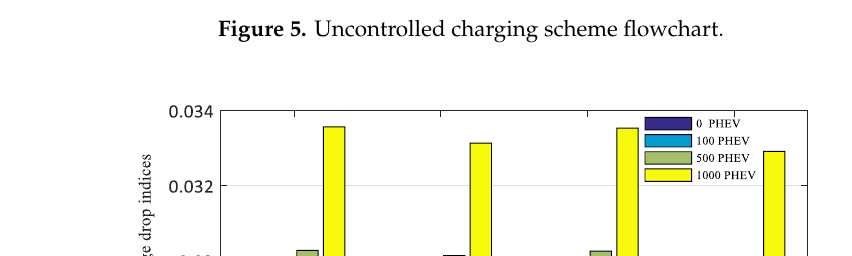
Figure 5. Uncontrolled charging scheme flowchart.